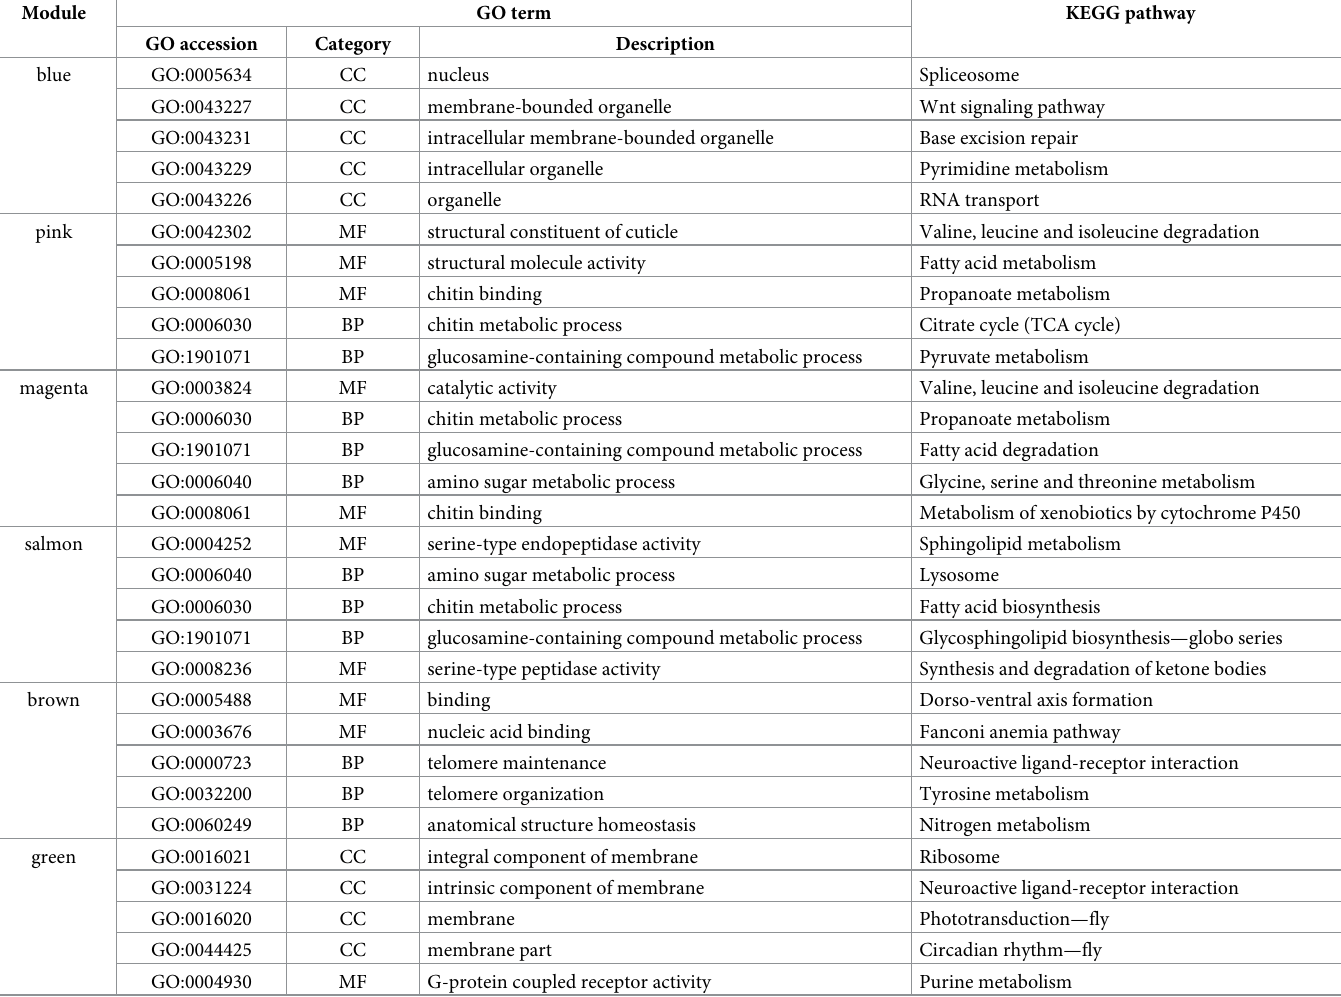
Table 1. Top 5 GO terms and KEGG pathways of the blue, pink, magenta, salmon, brown and green module.